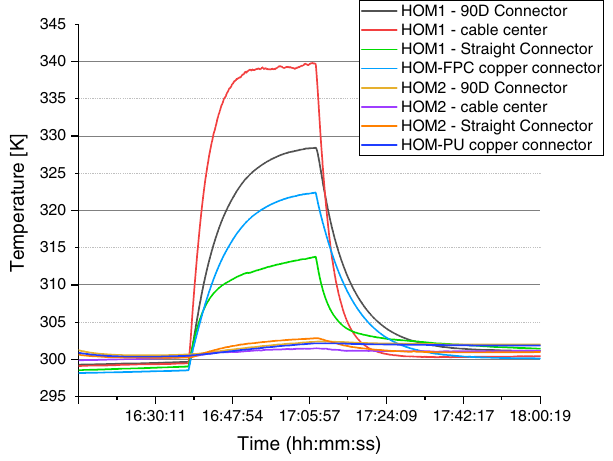
FIG. 4. Temperature of HOM1 and HOM2 cables and feed- throughs versus time during cable testing for plasma processing: input power of 100 W for 30 min. HOM1 denotes the cable connected to the HOM FPC side and used as an input line, HOM2 denotes the cable connected to the HOM pickup side and used as the transmitted line. For both HOM1 and HOM2 cables, the 90° connector (shown in Fig. 2, left) is the side connected to the HOM coupler, while the straight connector is the opposite end of the cable. The HOM-FPC and HOM-PU copper connectors denote the sensors placed on the HOM antenna feedthroughs, shown in Fig. 2,